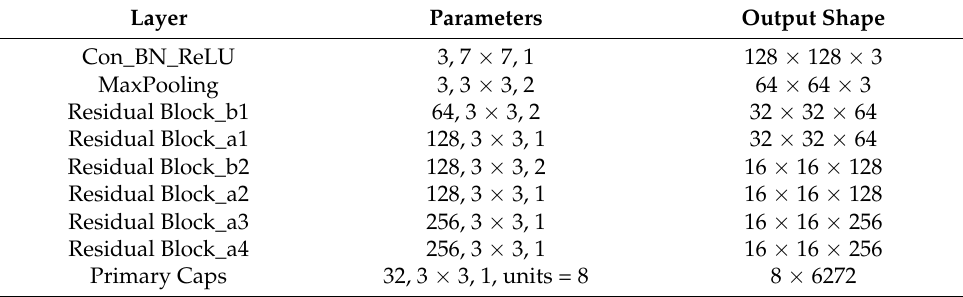
Table 4. Parameters of TongueCaps.